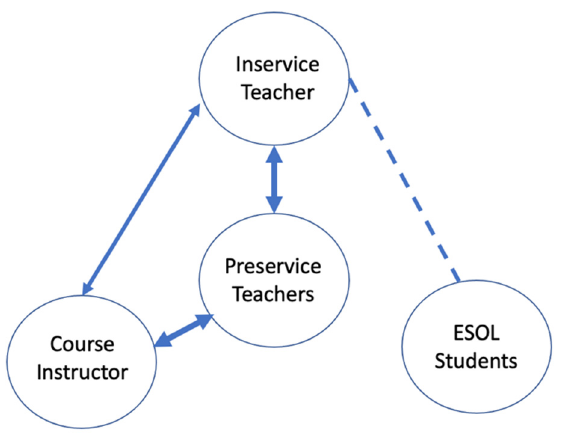
Figure 3. Planning stage.